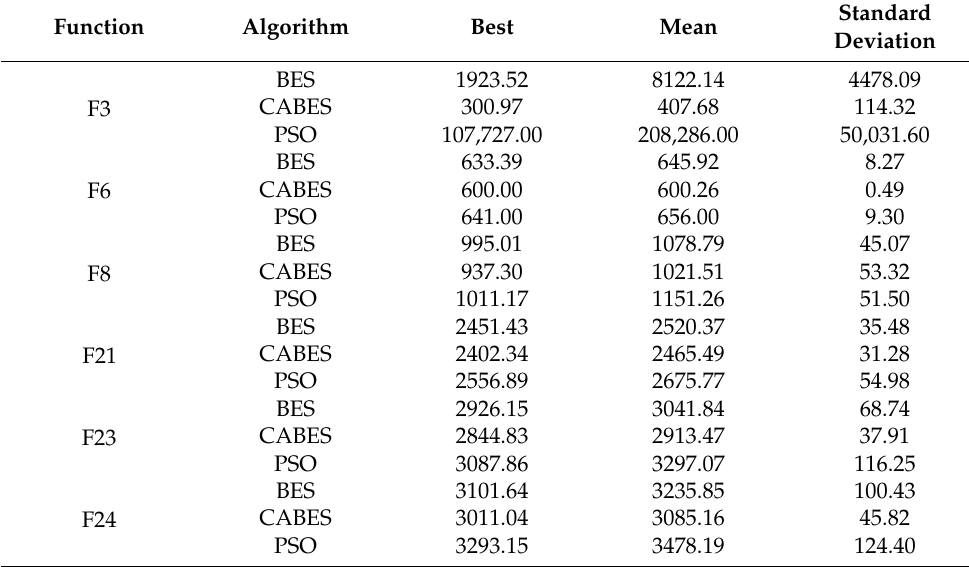
Table 2. Optimization results of CEC2017 test